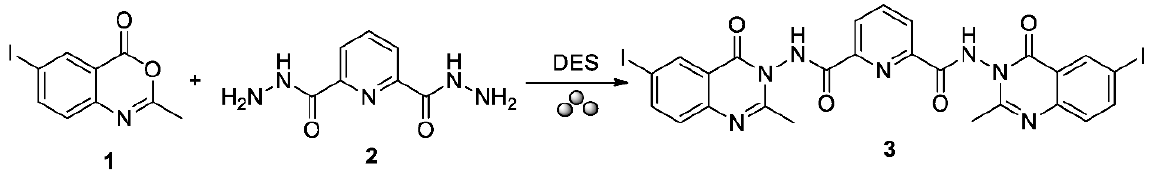
Figure 3. Synthesis of N 2 , N 6 -bis(6-iodo-2-methyl-4-oxoquinazolin-3(4 H )-yl)pyridine-2,6-dicarbox- amide.